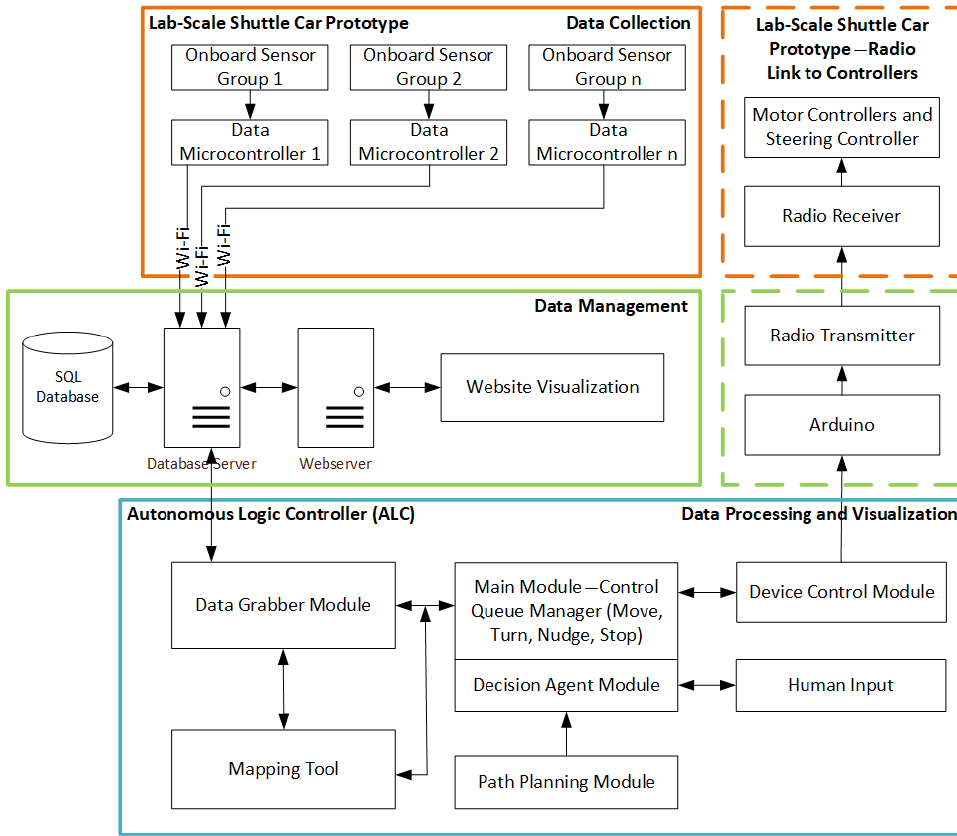
Figure 7. Schematic of data flow and management.